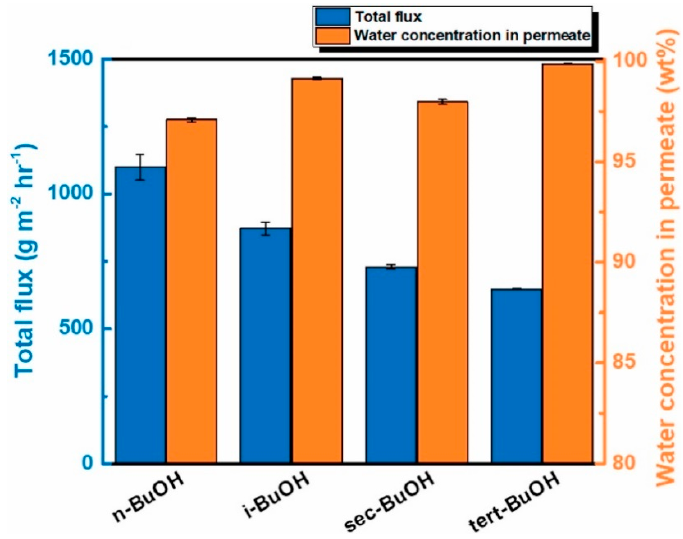
Figure 6. Performance of the pervaporation procedure for separating various butanol isomer/water combinations at 25 °C using the TA0.075_TMC0.4_NGQD(50) membrane.